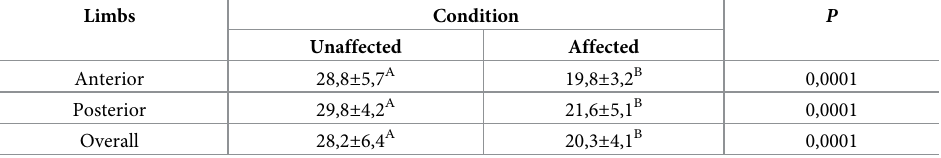
Table 2. Mean and standard deviation of the weight distribution (%) of the affected limbs and their unaffected contralateral limb after oligofructose-induced laminitis. Limbs Condition P Unaffected Affected Anterior 28,8 ± 5,7 A 19,8 ± 3,2 B 0,0001 Posterior 29,8 ± 4,2 A 21,6 ± 5,1 B 0,0001 Overall 28,2 ± 6,4 A 20,3 ± 4,1 B 0,0001 Superscript letters on the same line indicate differences between the unaffected and affected members through Bonferroni